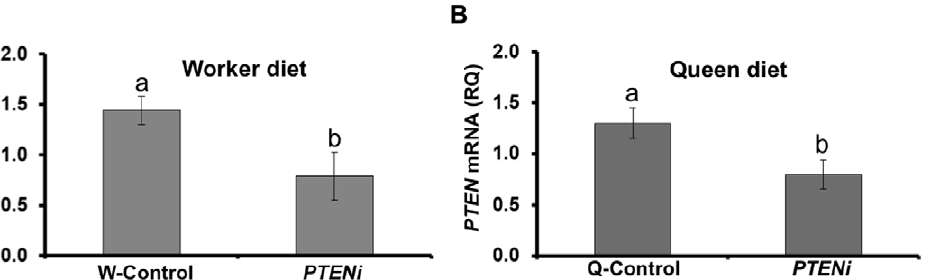
Figure 3. PTEN RNAi during larval development. Test of gene knockdown in honey bee larvae fed worker (A) vs. queen (B) diet in each of two separate experiments (n=24). The larvae were fed with a higher dosage (450 m g/ml) of dsRNA which elicited significant PTEN knockdown (A,B). Bars represent mean 6 s.e, different letters (a, b) denote significantly different groups, main effect ANOVA, p , 0.05).